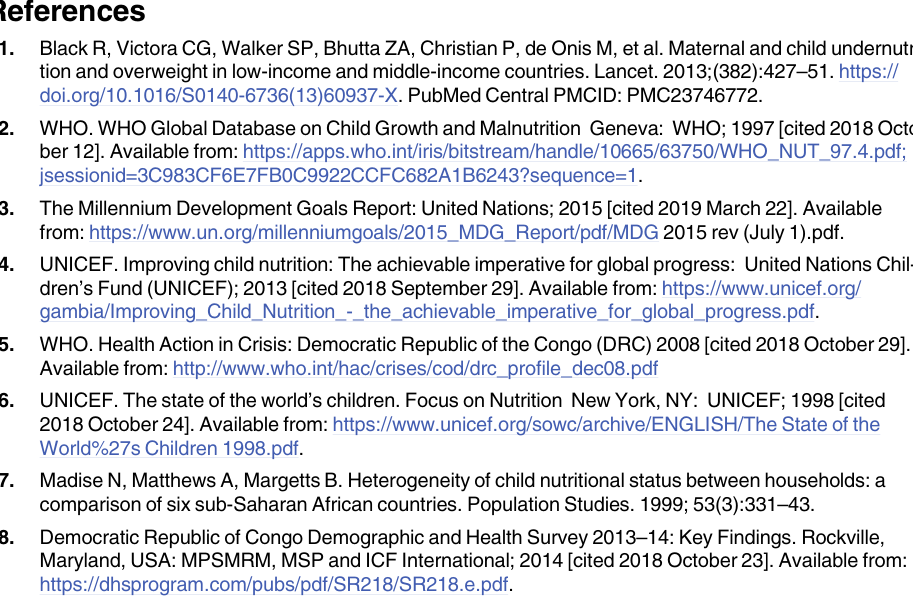
S3 Table. Post-hoc analysis of the association between joint decision making compared with women’s decision making alone on stunting and wasting. S4 Table. Post-hoc analysis of the association between no participation in decision-making compared to women’s decision making alone on stunting and